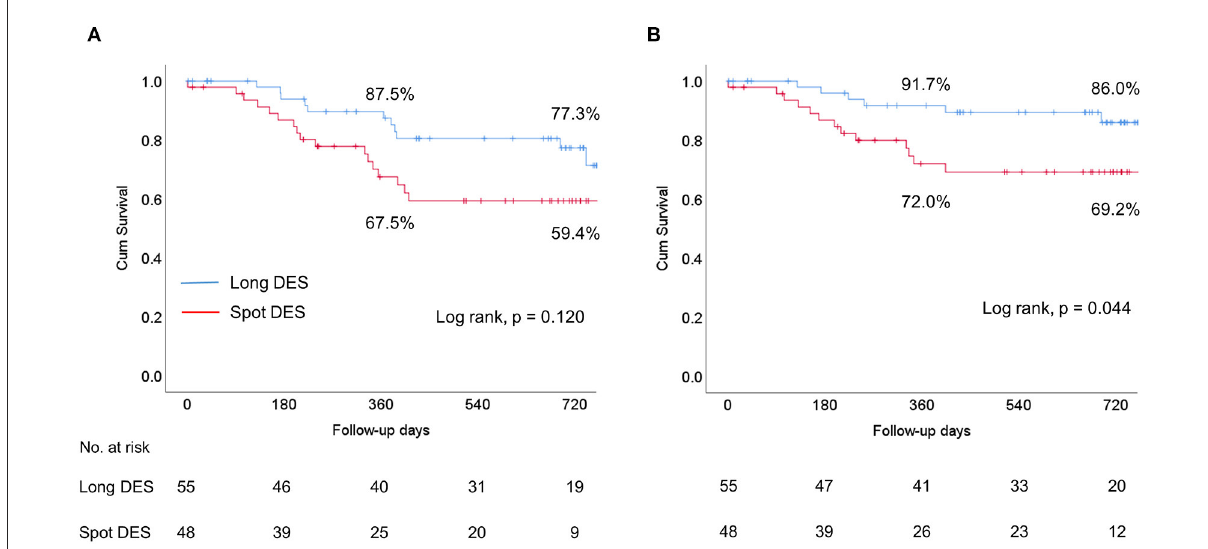
FIGURE2 Kaplan-Meier survival curves comparing the long drug-eluting stent (DES) group vs. the spot DES group. (A) Primary patency. (B) Target lesion revascularization (TLR)-free survival. Cum,